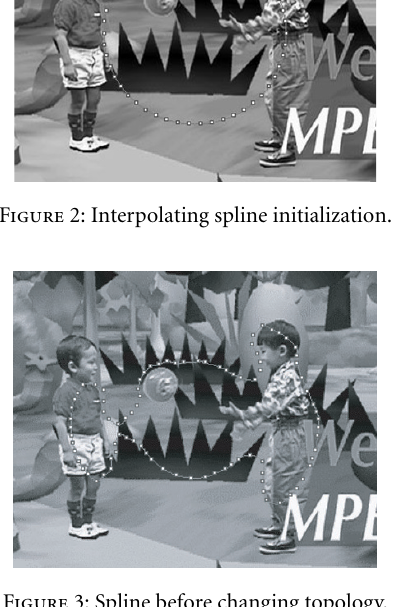
Figure 3: Spline before changing topology.